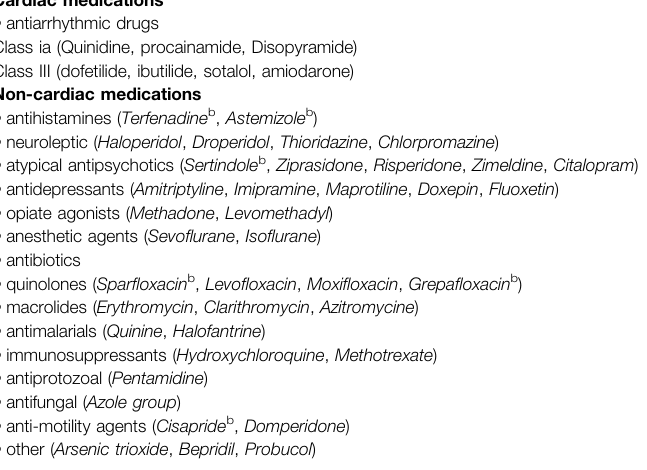
TABLE 5 | Cardiac and non-cardiac drugs associated with QT interval prolongation a . Cardiac medications (cid:129) antiarrhythmic drugs Class ia (Quinidine, procainamide, Disopyramide) Class III (dofetilide, ibutilide, sotalol, amiodarone) Non-cardiac medications (cid:129) antihistamines ( Terfenadine b , Astemizole b ) (cid:129) neuroleptic ( Haloperidol , Droperidol , Thioridazine , Chlorpromazine ) (cid:129) atypical antipsychotics ( Sertindole b , Ziprasidone , Risperidone , Zimeldine , Citalopram ) (cid:129) antidepressants ( Amitriptyline , Imipramine , Maprotiline , Doxepin , Fluoxetin ) (cid:129) opiate agonists ( Methadone , Levomethadyl